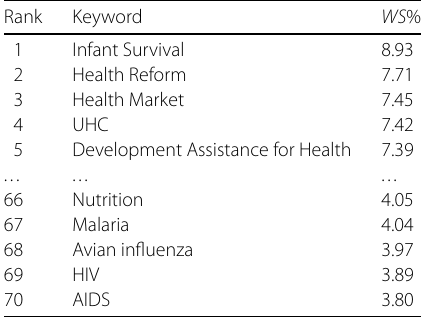
Figure 5 (Left) The intensity of World Bank co-appearances according to WS %, from high (red) to low (blue). (Right) The relationship between co-appearances ( x -axis) and direct mentions ( y -axis) of World Bank for all issues